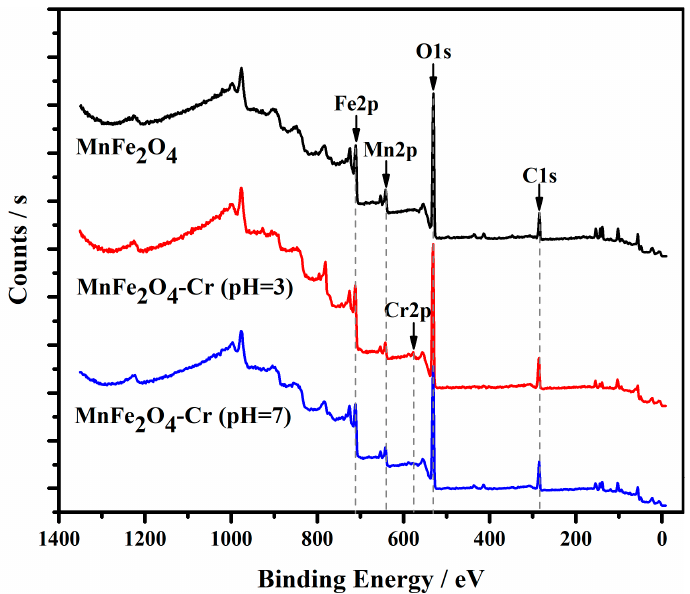
Figure 8. The XPS spectra of MnFe 2 O 4 adsorbent ( a ), MnFe 2 O 4 − Cr (pH = 3) ( b ), MnFe 2 O 4 -Cr (pH = 7) ( c ).